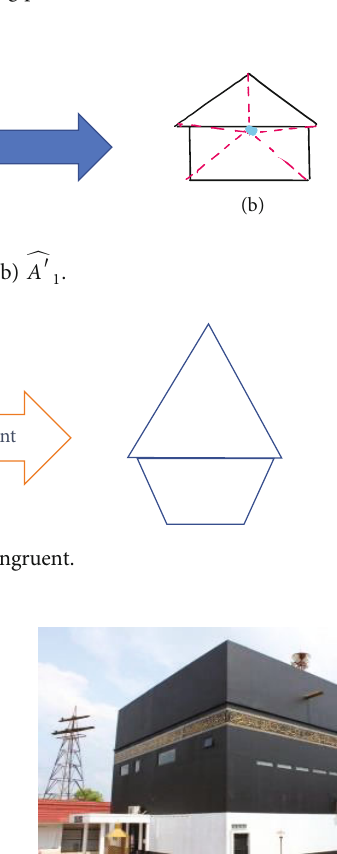
Figure 10: Three vanishing points.